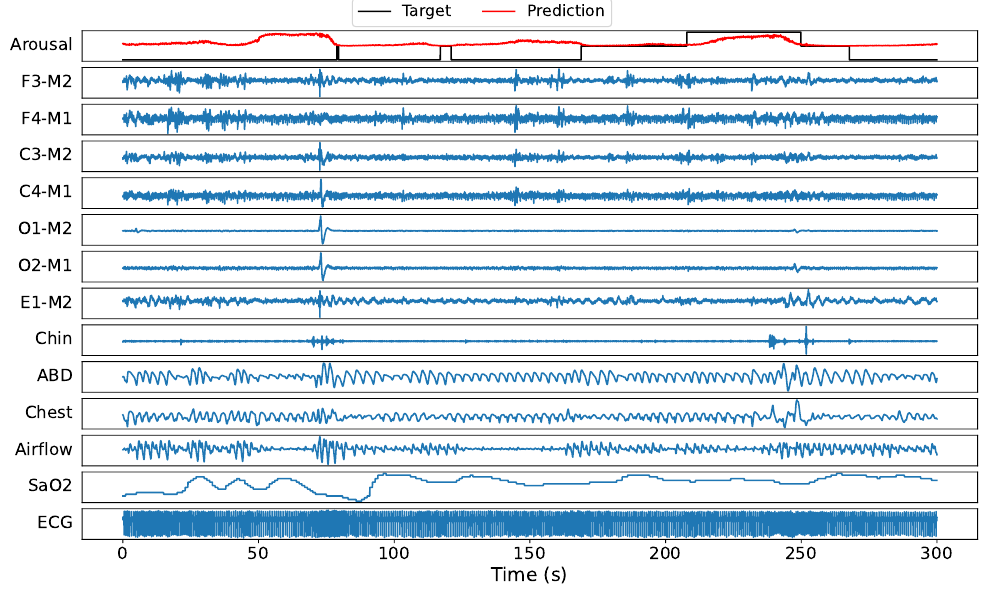
Figure 5. A 300 s window example of a PSG recording of a randomly selected (from the test set) subject with target labels (arousal = 1, nonarousal = 0, not scored = − 1) and DeepSleep 2.0 (model 2) predicted sleep arousal probabilities.